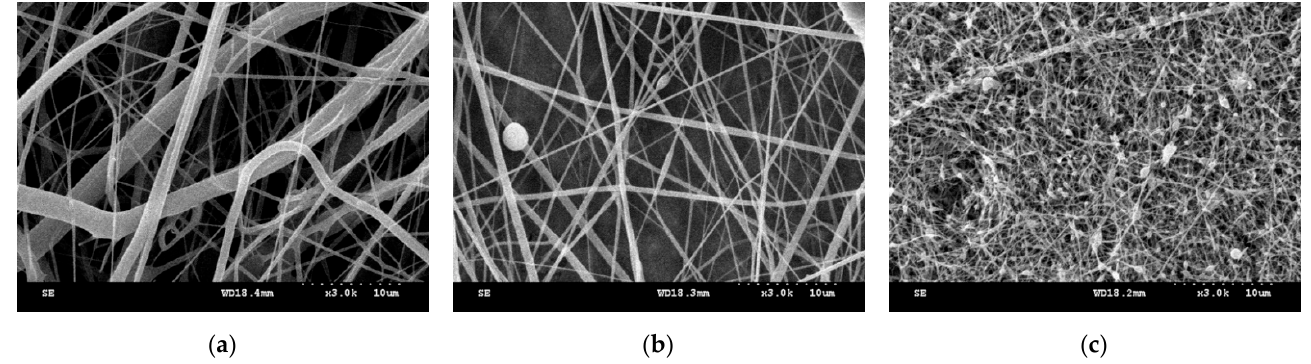
Figure 2. Fiber morphology of PVA nanofibrous membranes as related to a voltage being ( a ) 30 kV, ( b ) 50 kV, and ( c ) 70 kV. ( b ) 50 kV, and ( c ) 70